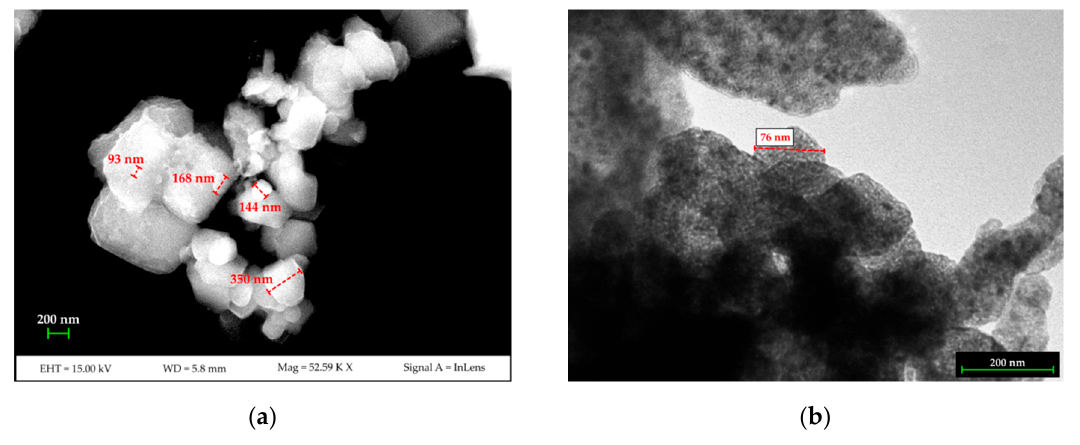
Figure 1. FESEM ( a ) and TEM ( b ) images of the synthesized nano-Ca(OH) 2 .